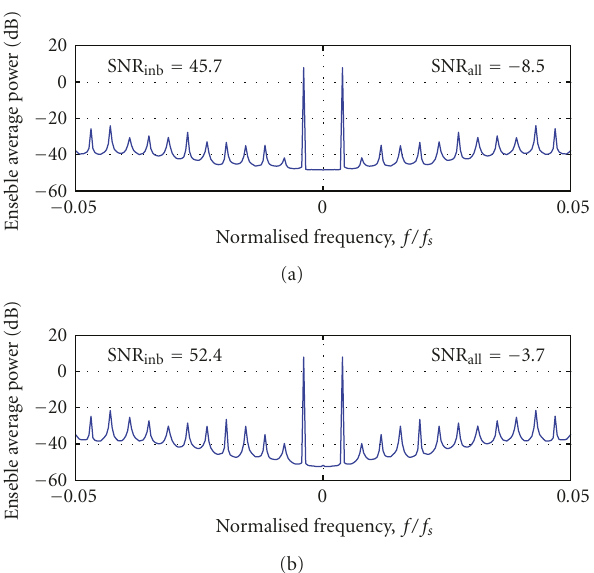
Figure 6: Output of the proposed format conversion structure in Figure 3 and output of its traditional counterpart. The oversam- pling ratio is always 128.